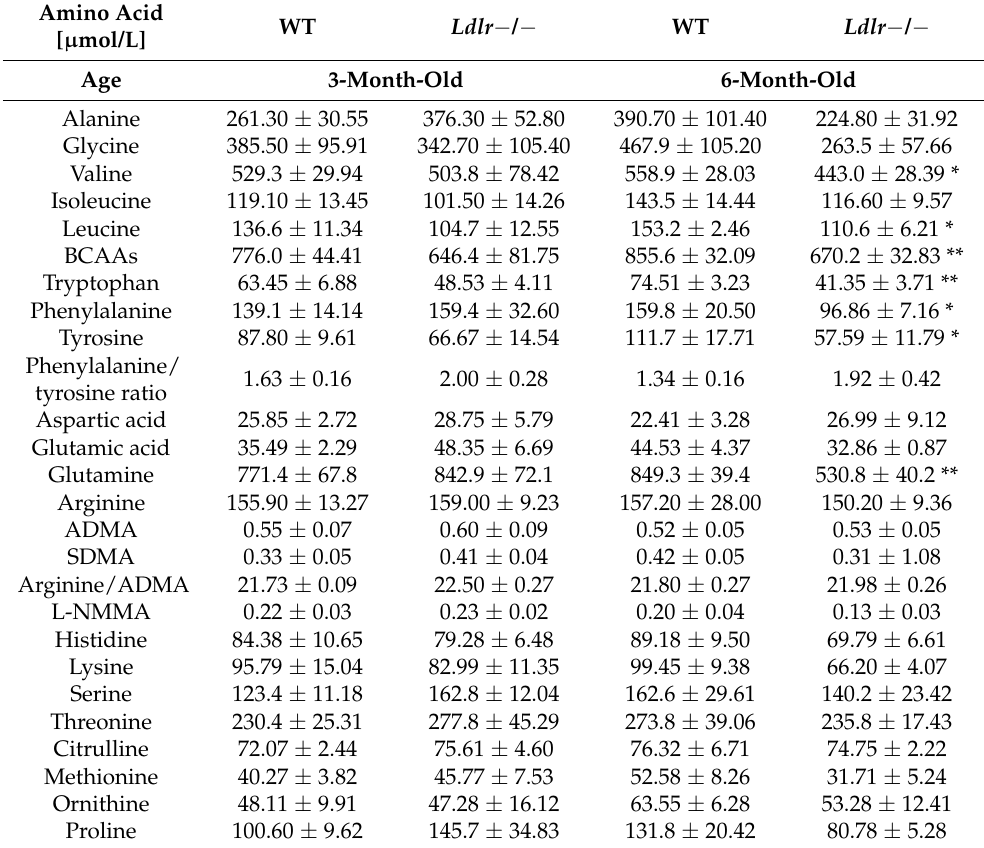
Table 1. Serum amino acids in Ldlr − / − mice. Serum amino acids (AAs) in 3- and 6-month-old dyslipidemic ( Ldlr − / − ) and wild-type (WT) mice, n = 4–7; * p < 0.05; ** p <